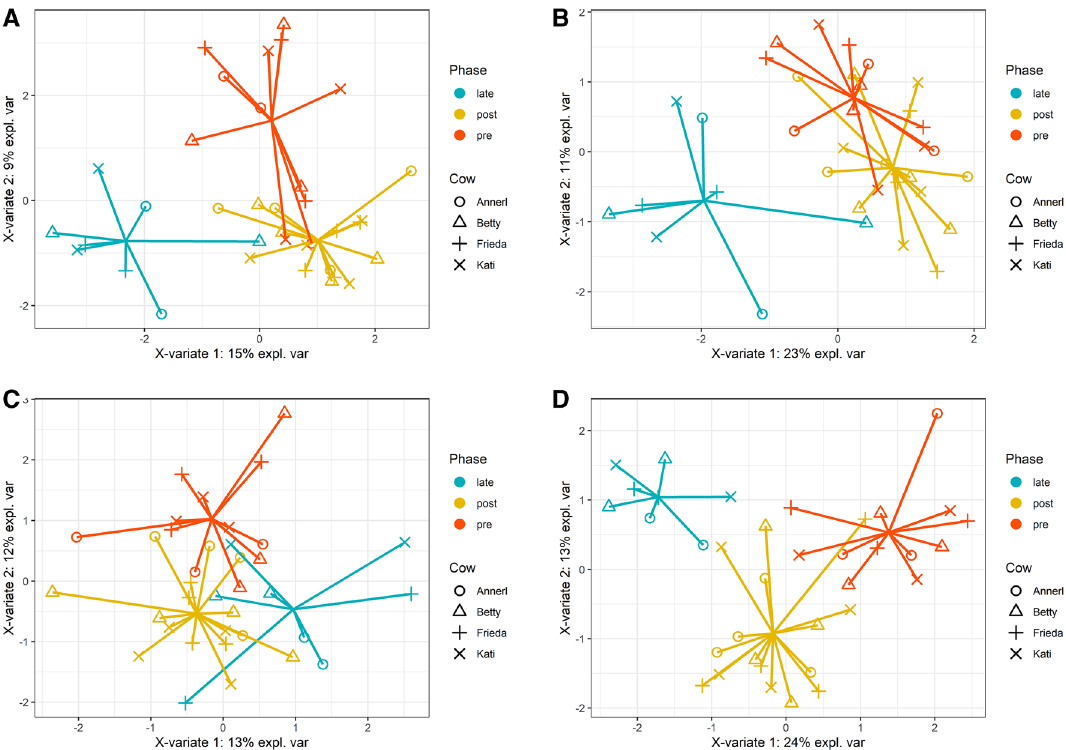
Figure 5. Supervised Clustering of the results of Bovela treatment (group C), three components with a maximum of five features each. ( A ) sPLS-DA using all parameters (AUROC: “pre” vs others: 0.997, “post” vs others: 0.950, “late” vs others: 1.000); ( B ) sPLS-DA using blood parameters (AUROC: “pre” vs others: 0.896, “post” vs others: 0.847, “late” vs others: 0.987); ( C ) sPLS-DA using milk parameters (AUROC: “pre” vs others: 0.931, “post” vs others: 0.906, “late” vs others: 0.973); ( D ) sPLS-DA using the parameters analyzed by external laboratory (AUROC: “pre” vs others 0.979, “post” vs others: 0.959, “late” vs others: